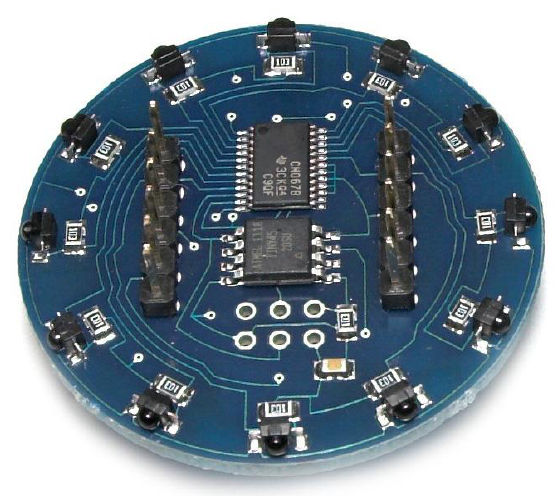
Figure 1. Infrared (IR) angle-of-arrival (AoA) sensor prototype.